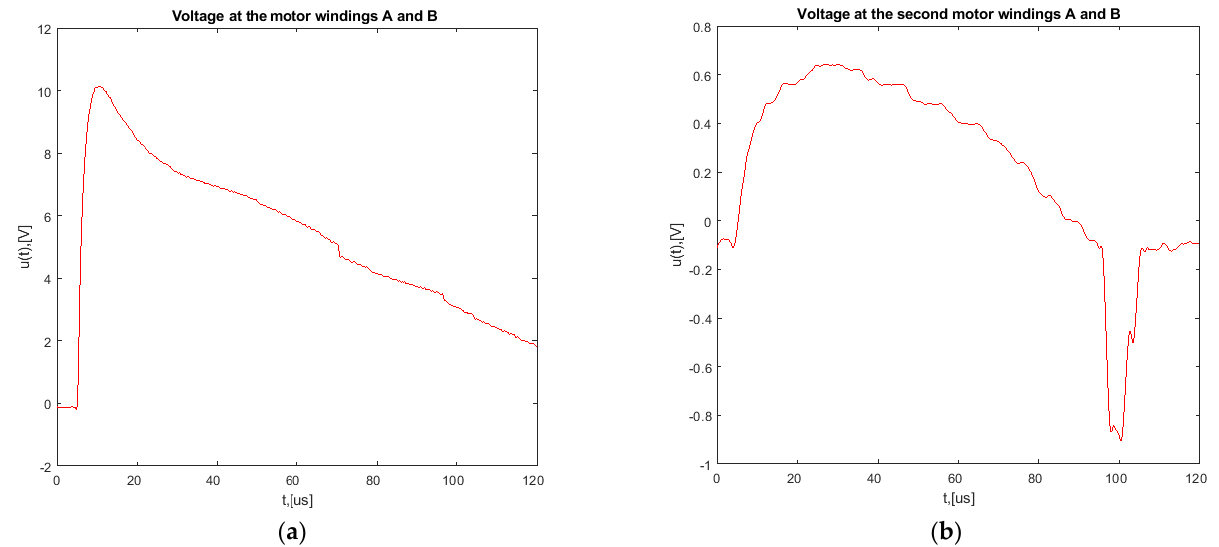
Figure 7. ( a ) Input—Voltage measured at the A and B pins of the first motor windings; ( b ) Output—Voltage measured at the A and B pins of the second motor windings A and B.